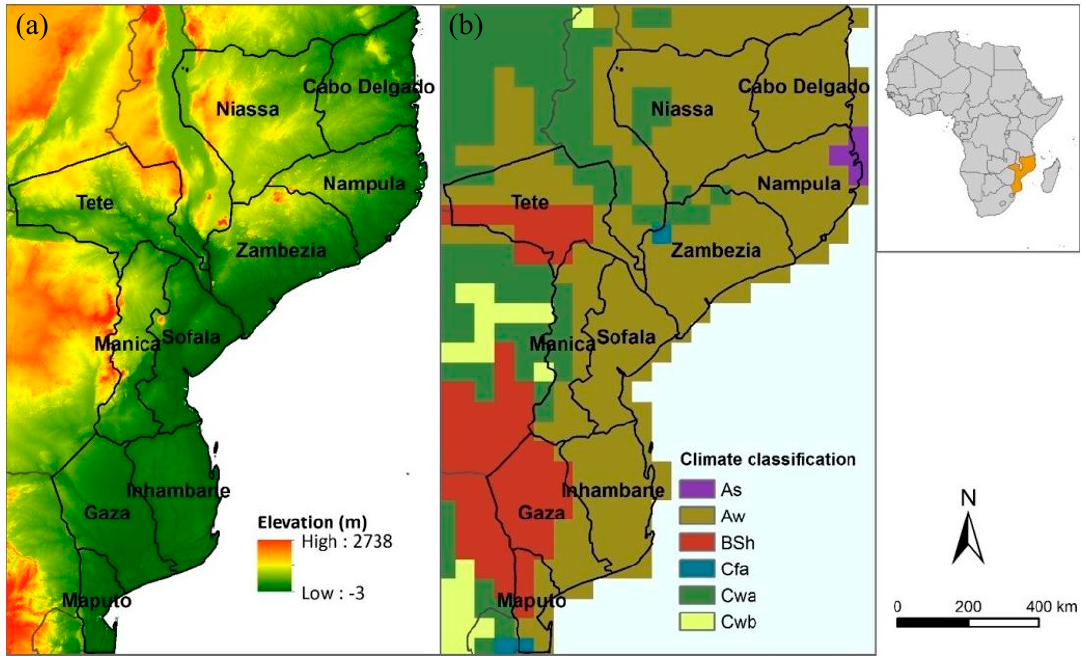
Figure 1. ( a ) Elevation (MapMart, 2014 (http://www.mapmart.com/)) and ( b ) climate of Mozambique using Köppen classification [25]. As = Equatorial savannah with dry summer, Aw = Equatorial savannah with dry winter, BSh = Hot Steppe climate, Cfa = Warm temperate climate, fully humid with hot summer, Cwa = Warm temperate climate with dry winter and hot summer, and Cwb = Warm temperate climate with dry winter and warm summer. Source: Gelcer et al. (2018) [3].